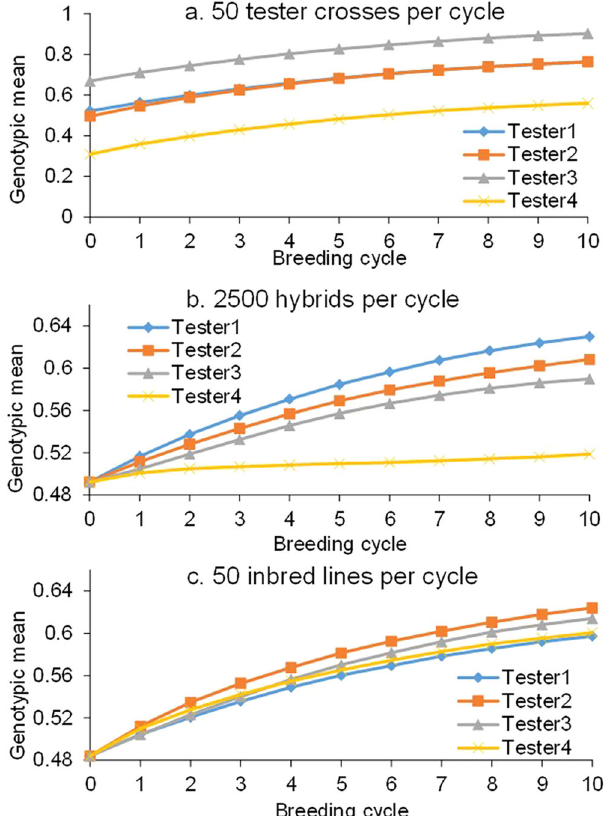
Fig. 3 Genotypic means of tester crosses, hybrids with one other heterotic group, and inbred lines per se during 10 cycles of hybrid breeding. a Genotypic means of 50 tester crosses. b Genotypic means of 2500 hybrids with one other heterotic group. c Genotypic means of 50 inbred lines per se. The ordinate axes of the three sub fi gures are different for a better illustration of the differences among the four